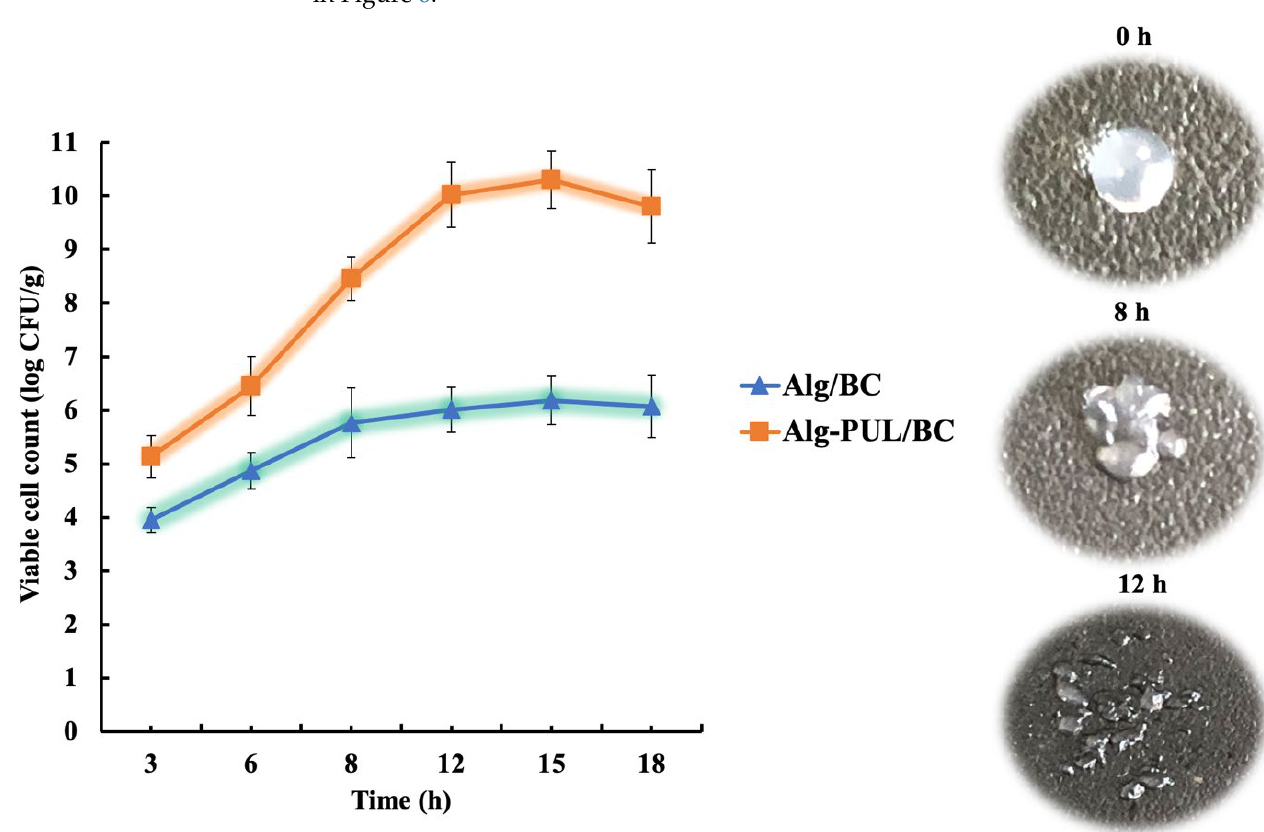
Figure 6. LGG release profile from beads into simulated colon fluid (SCF). All the samples were sequentially immersed in simulated gastric fluid (SGF) and simulated duodenum fluid (SDF) for 4 h before transferring into SCF.